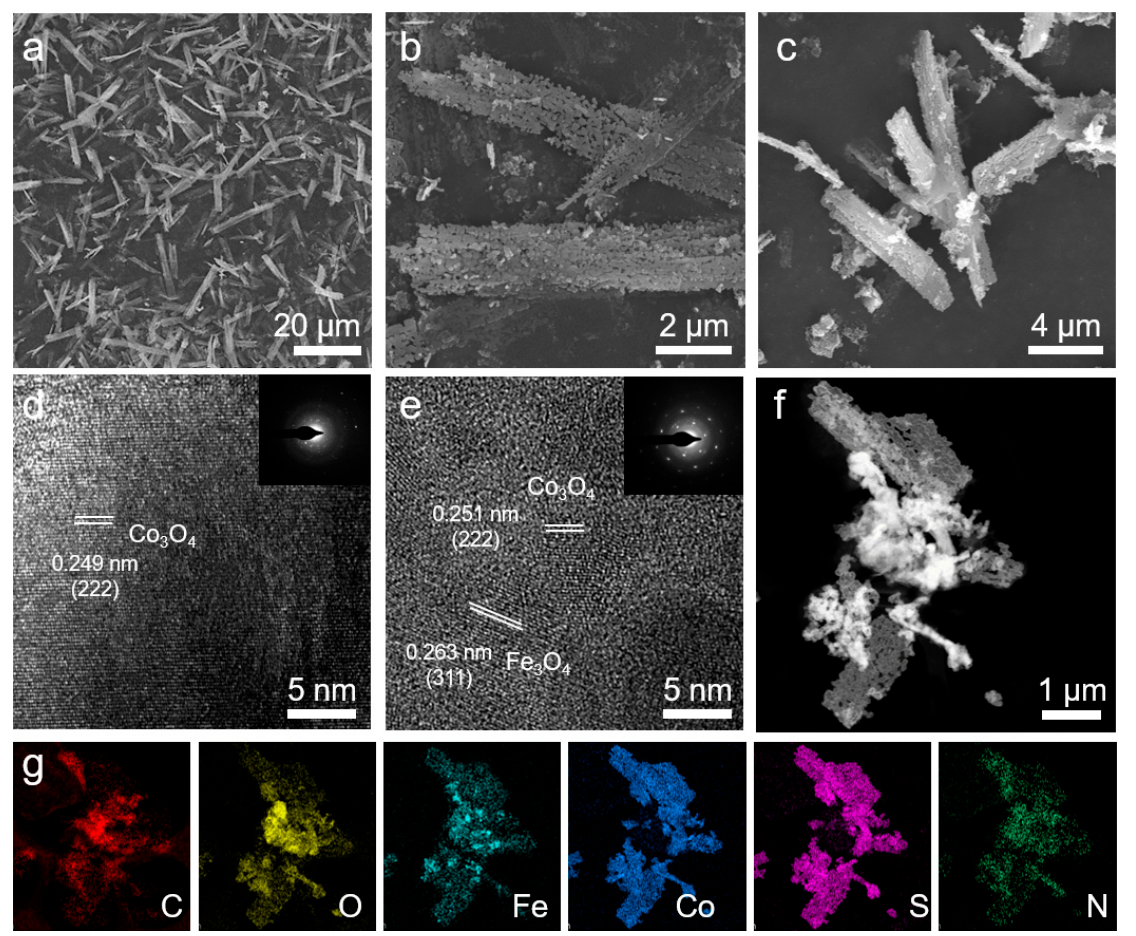
Figure 1. SEM images of ( a ) precursor, ( b ) Fe–Co 3 O 4 , and ( c ) Fe–Co 3 O 4 –S/NSG. HRTEM image of ( d ) Co 3 O 4 –S/NSG and ( e ) Fe–Co 3 O 4 –S/NSG (inset: SAED patterns). ( f ) HAADF-STEM of Fe–Co 3 O 4